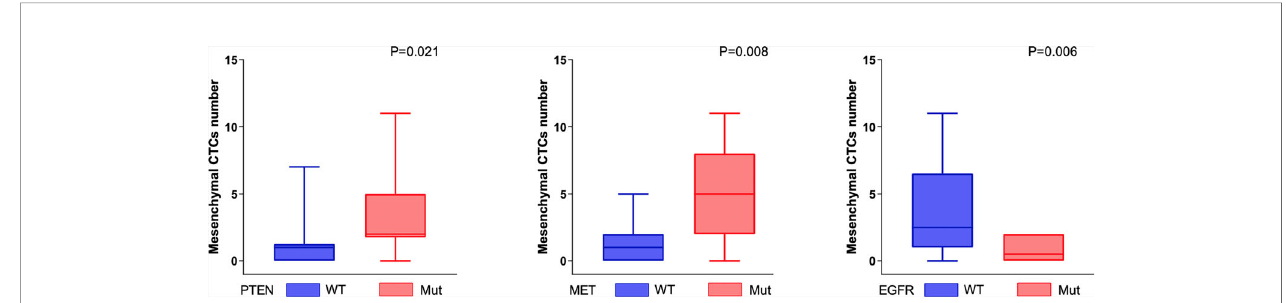
FIGURE 3 | Genomic alterations associated with mesenchymal CTCs. The number of mesenchymal CTCs was positively correlated with the somatic genomic alterations in PTEN and MET genes (PTEN, P = 0.021; MET, P = 0.008, Mann – Whitney U test), and negatively correlated with the somatic genomic alterations in EGFR (P = 0.006, Mann – Whitney U